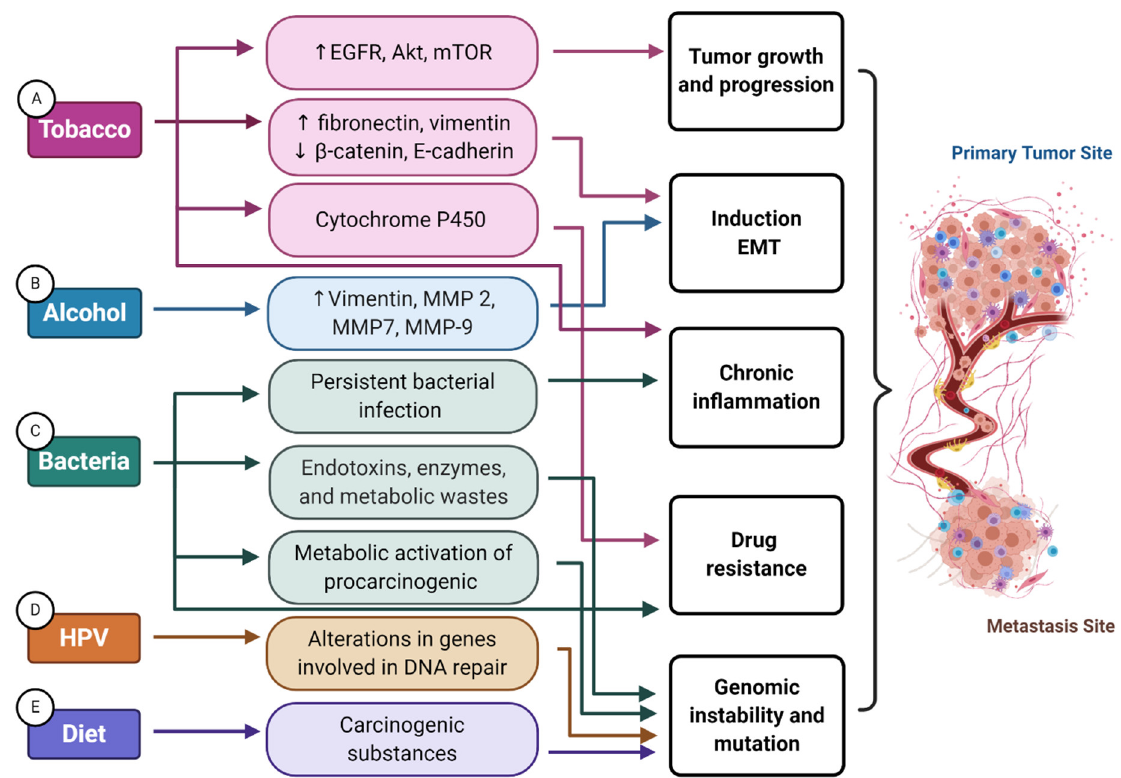
Figure 2. Mechanisms involved in environmental factor support of the onset and progression of head and neck cancer. ( A ) The expression of alpha-7 nicotinic acetylcholine receptors (nAChRs) promotes proliferation and migration through the phosphorylation of epidermal growth factor receptor (EGFR), protein kinase B (Akt), mammalian target of rapamycin (mTOR), and the stimulation of beta-adrenergic receptors. Nicotine upregulates the expression of mesenchymal proteins (fibronectin and vimentin), whereas it downregulates epithelial proteins (beta-catenin and E-cadherin), thereby supporting cell motility and invasion through induction of epithelial–mesenchymal transition (EMT). Nicotine can perturb drug efficacy via cytochrome P450 (CYP)-mediated metabolism, glucuronidation, and/or protein binding, which may impact the efficacy of anticancer drugs. Tobacco consumption also promotes a pro-inflammatory tumor microenvironment, further supporting tumor growth. ( B ) Alcohol is capable of directly upregulating vimentin, matrix metalloproteinase (MMP)-2, MMP-7, and MMP-9, promoting an EMT invasive phenotype and extracellular matrix remodeling. ( C ) Particular bacteria participate